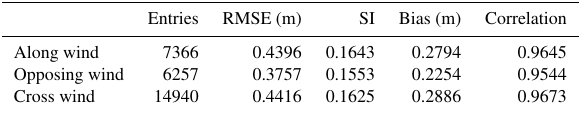
Table 6. Comparison of the data quality, organized by the wind di- rection relative to the satellite flight direction, for Sentinel-3A